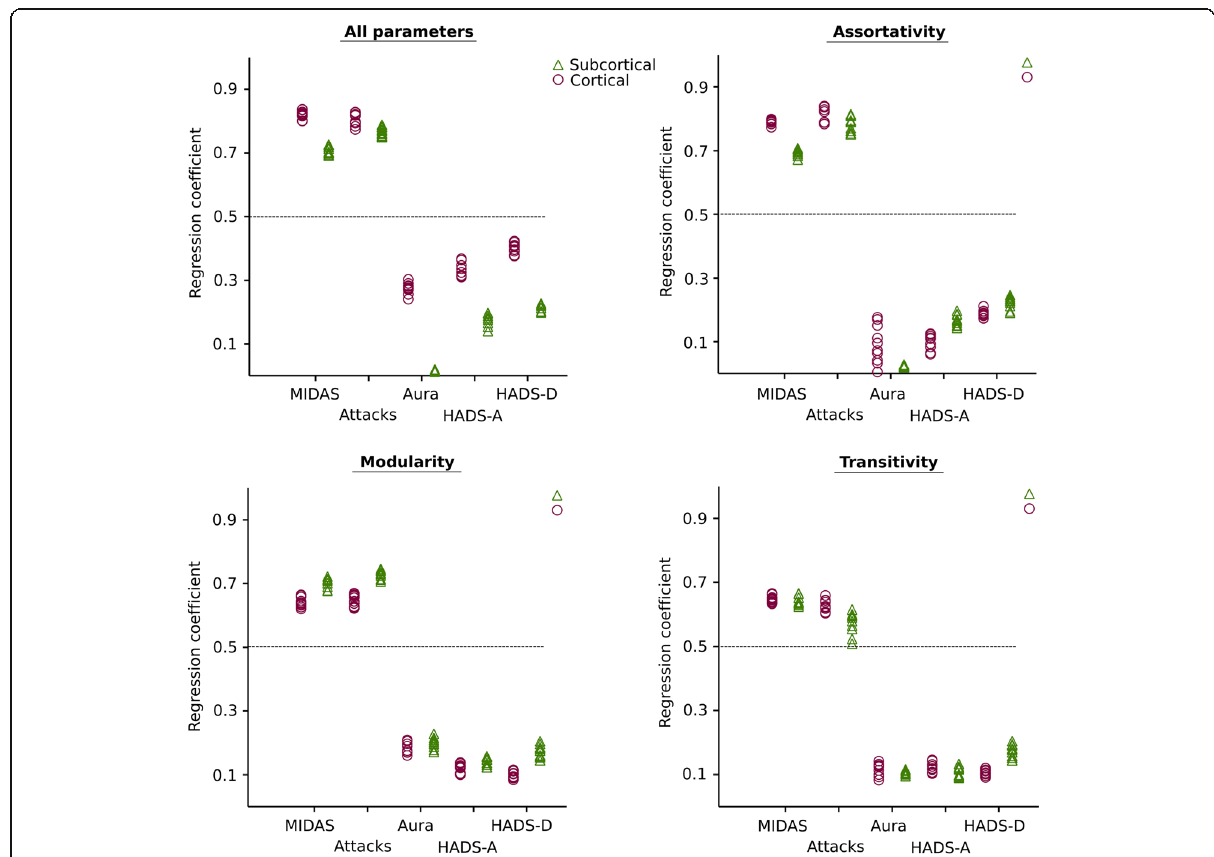
Fig. 6 Plots showing the results of the SVR analysis, for predicting MIDAS, attacks per month, aura, HADS-A and HADS-D using network measures assortativity, transitivity and modularity obtained using cortical thickness and subcortical volumes. As the cross-validation was performed 10 times, each dot indicates the regression coefficient obtained for each validation. Dots above the dashed line indicate robust (r > 0.5)